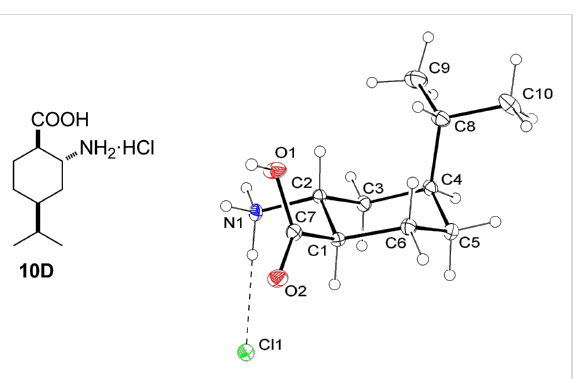
Figure 1: Structure of 10D and an ORTEP plot of its configuration.